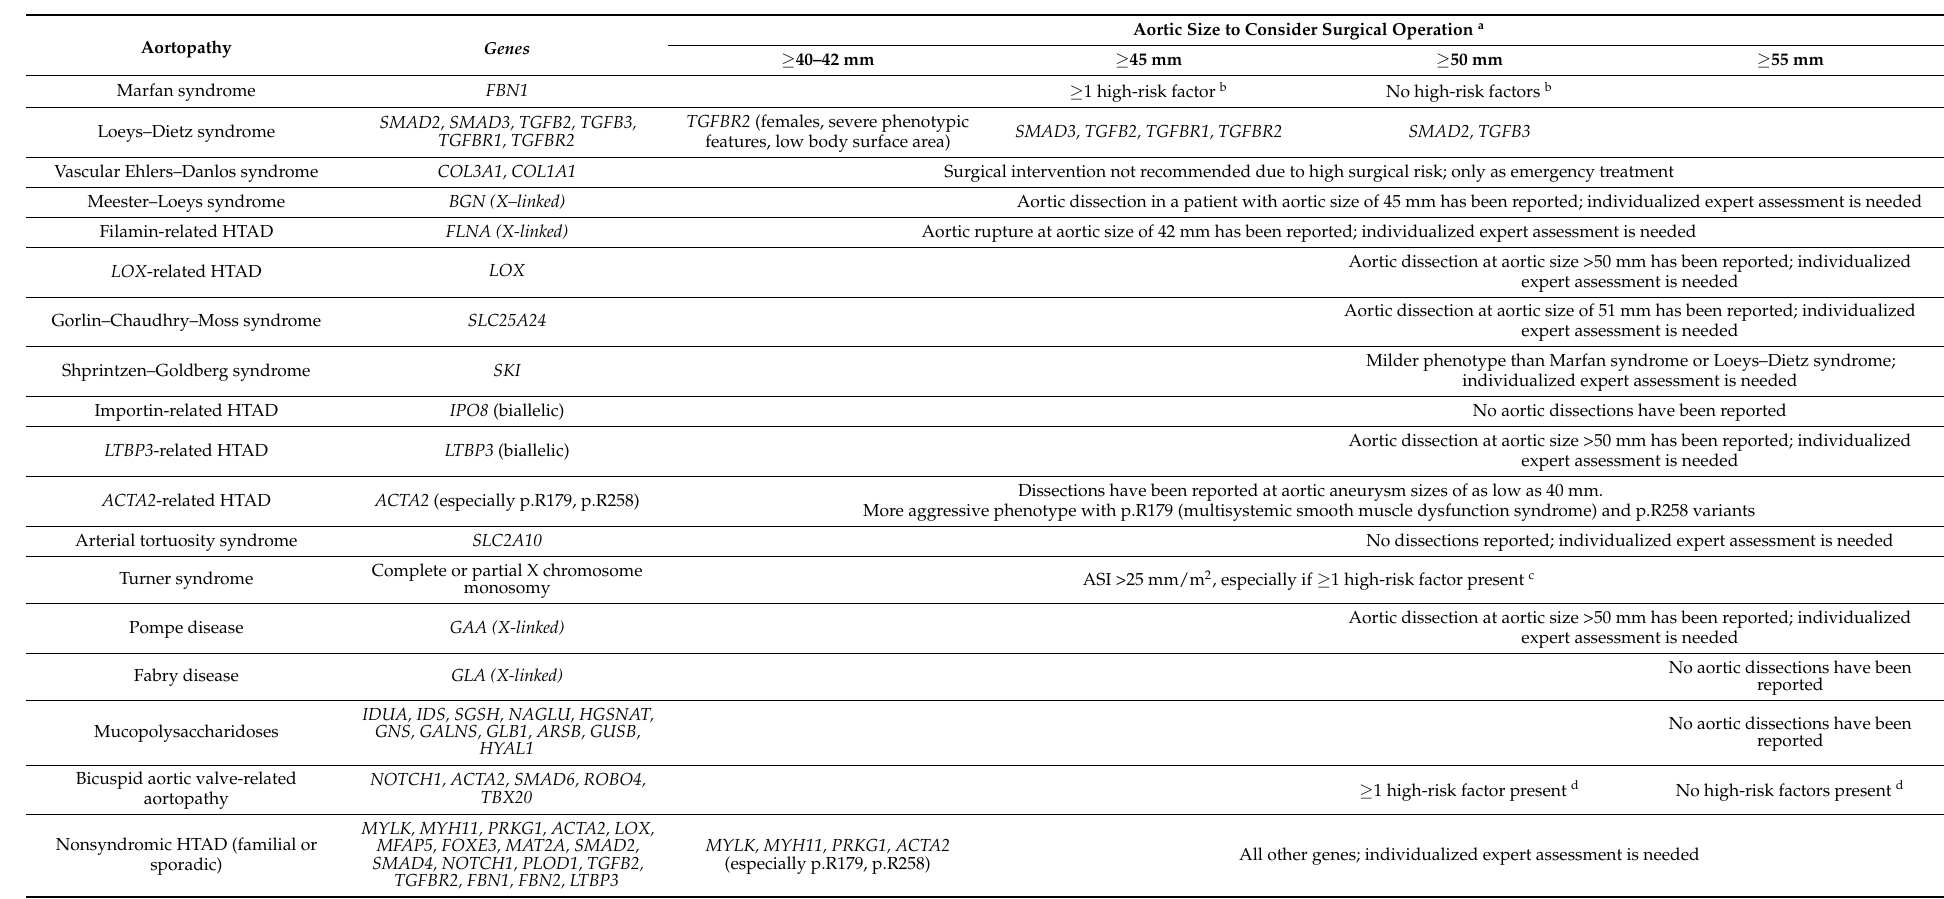
Table 2. Genotype–phenotype correlations to be considered before aortic surgery in patients with heritable thoracic aortic